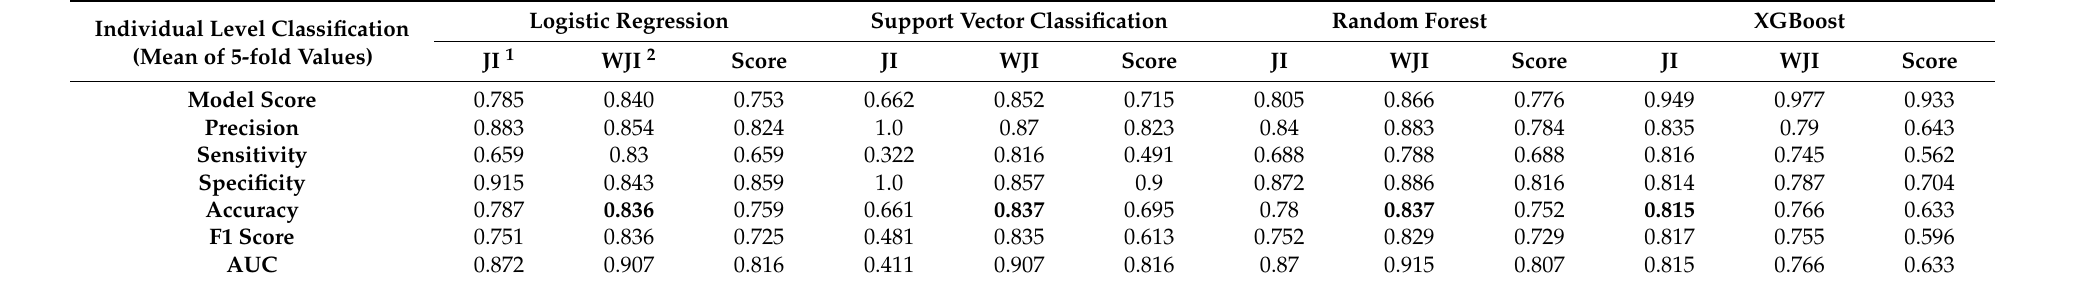
Table 7. Training and verification results of ALS_EG , ALS_CG and ALS_SELECT_FEA (individual level classification).